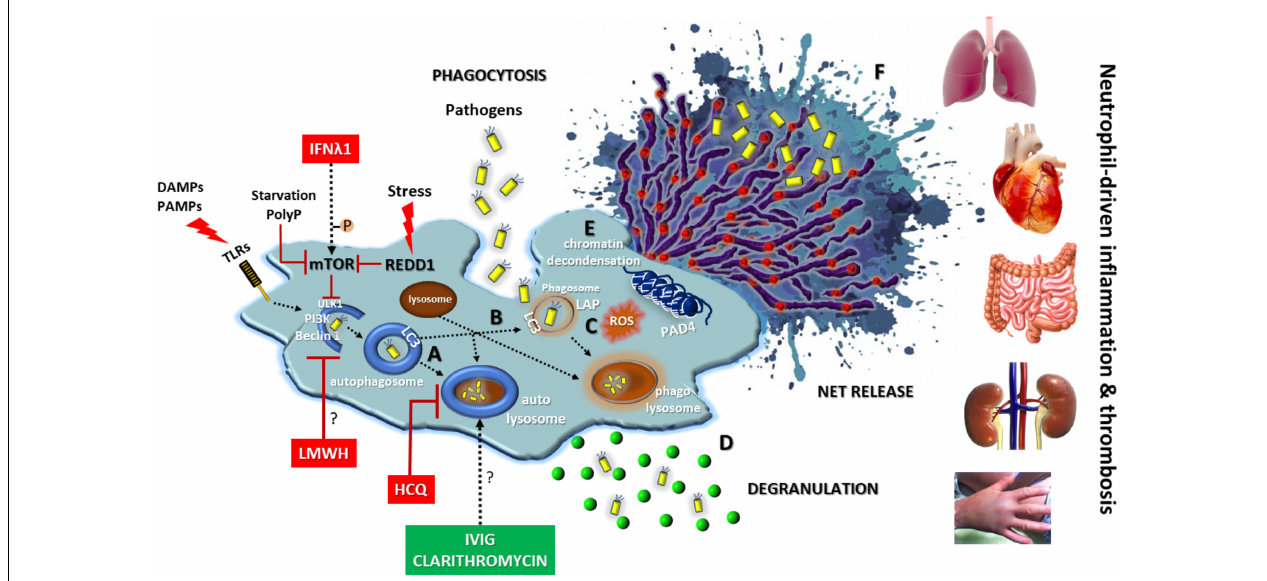
FIGURE 3 | Autophagy in neutrophil biology and disease. Autophagy has a central key role in neutrophil biology by (A) promoting intracellular elimination of pathogens (xenophagy), (B) accelerating phagocytosis (LAP), (C) interplaying with ROS, (D) regulating degranulation, (E) facilitating the resolution of inflammation via NETotic cell death, and (F) leading to externalization of various NET-bound bioactive proteins (depicted as red spherical spots). The enhancement of autophagic machinery (e.g., IVIG, clarithromycin) increases the antimicrobial capacity of neutrophils. On the contrary, blocking autophagy pathway at initial (e.g., IFN λ 1, LMWH) or late steps (e.g., HCQ) could be beneficial for neutrophil-driven inflammatory or thrombotic diseases. REDD1/mTOR pathway is a main regulator of autophagy in neutrophils. DAMPS, damage-associated molecular patterns; PAMPS, pathogen-associated molecular patterns; P, phosphorylation; PolyP, inorganic polyphosphate; REDD1, regulated in development and DNA damage responses 1; LAP, LC3-associated phagocytosis; ROS, reactive oxygen species; HCQ, hydroxychloroquine; LMWH, low molecular weight heparin; IVIG, intravenous immunoglobulin; Symbol “?” denotes the possible target of the anti-autophagic action.